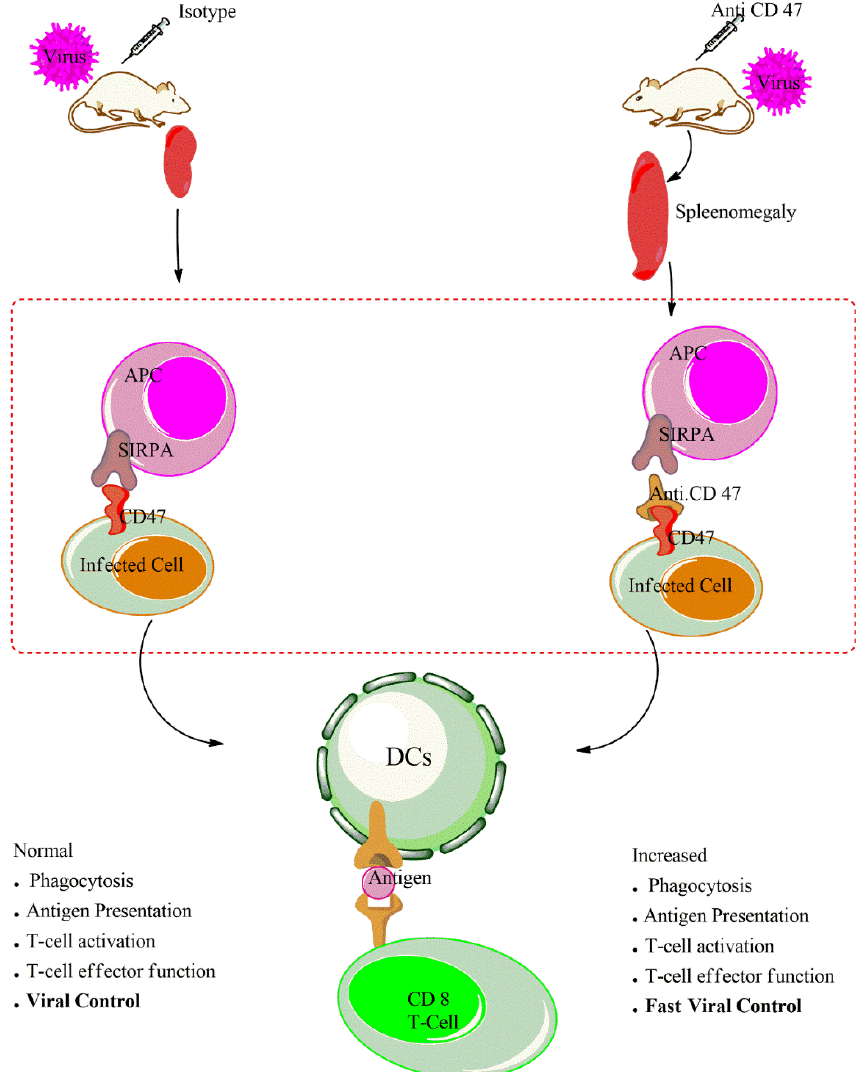
Figure 2. Treatment of isotype control to mice following a viral infection leads to limited change in the splenic architecture, normal phagocytosis, normal antigen presentation and therefore resulting to a normal activation and cytotoxicity of T cells. On the other hand, the administration of anti-CD47 antibody result to a splenomegaly, increases phagocytosis of infected cells, increase antigen presentation, enhances T cell activation and function and faster viral control.